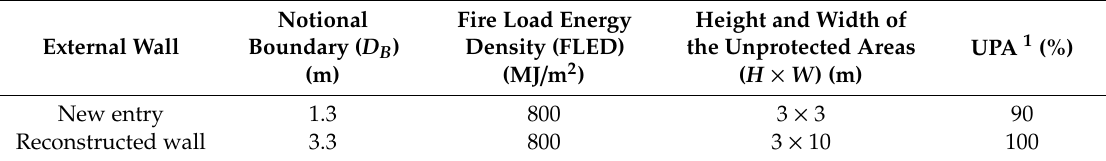
Table 1. Parameters evaluated and maximum allowable unprotected areas for new southern entry of McDougall